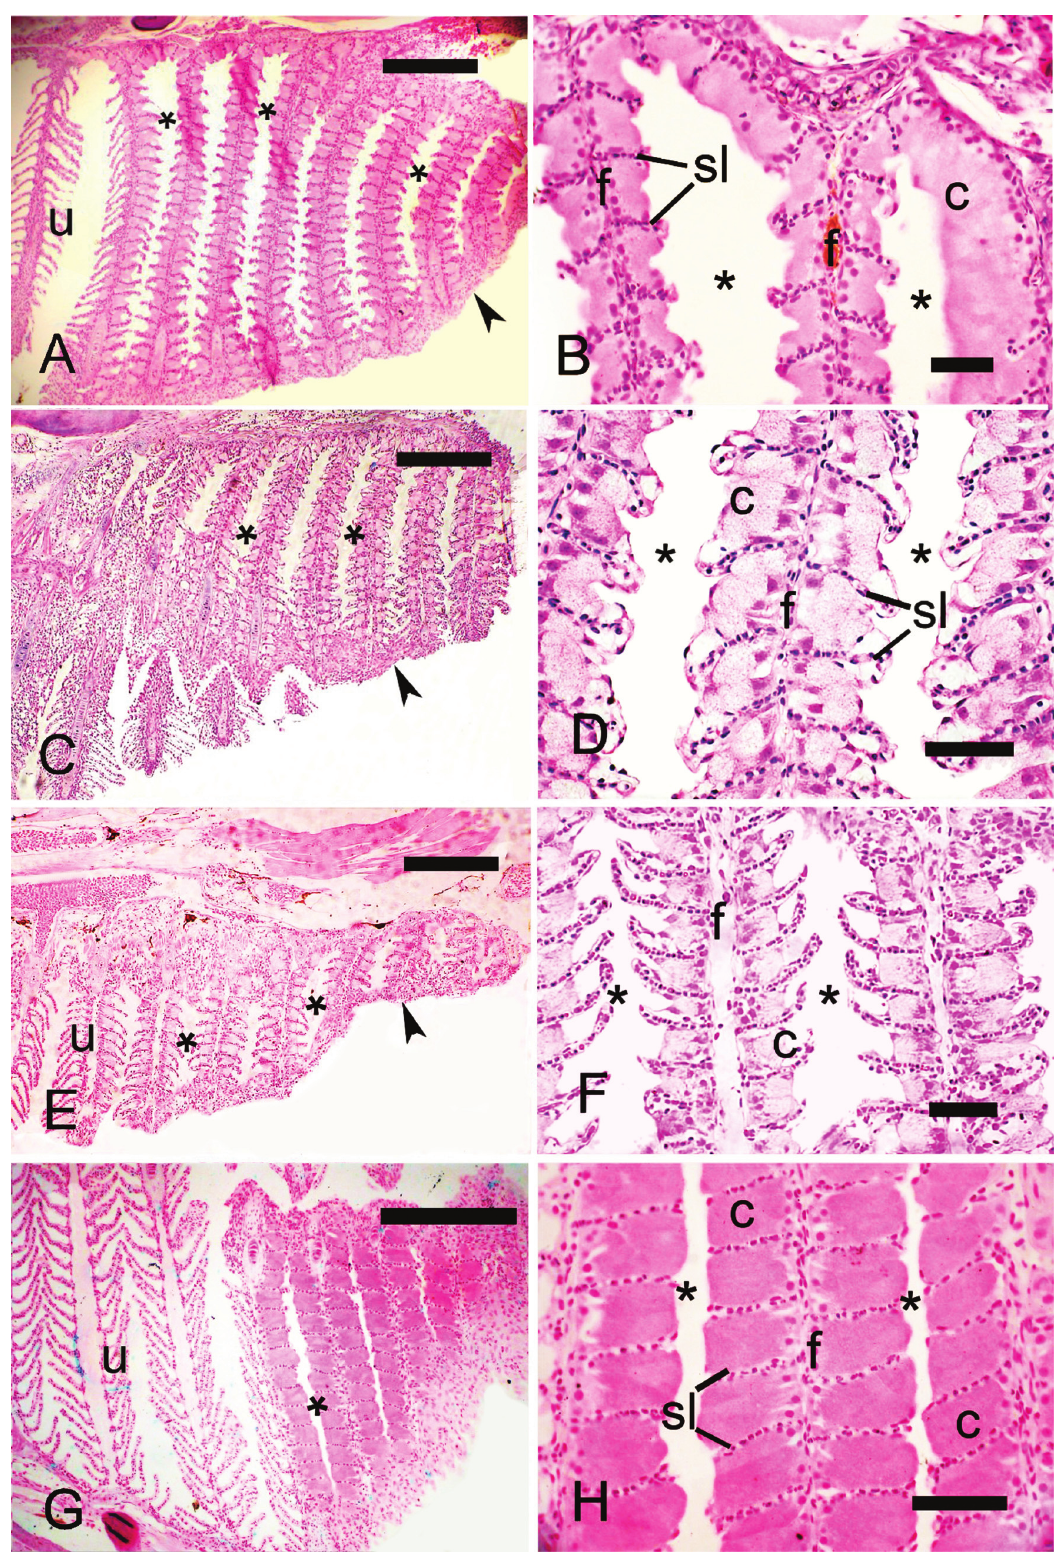
Fig. 4. Sagittal histological sections through first gill arches of males of the externally fertilizing cheirodontines, ( A, B ) Aphyocheirodon hemigrammus , ( C, D ) Heterocheirodon yatai , ( E, F ) Prodontocharax melanotus , ( G, H ) Serrapinnus heterodon . Asterisk = lumen of gill gland chamber; f = gill filaments; sl = gill secondary lamellae; u = unmodified gill filaments; arrowhead = gill gland cover; arrow = gill gland cover. Scale bars: 150 µm (A, C, E, G), 25 µm (B, D, F,